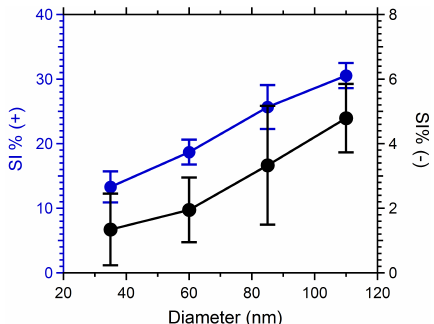
Figure 5. Percentage of total signal intensity (SI%) in positive ( + ) and negative ( − ) ion mass spectra from higher-order oligomers (molecular formulas having greater than 18 carbon atoms) vs. par- ticle diameter. Error bars represent 1 standard deviation for the five replicate